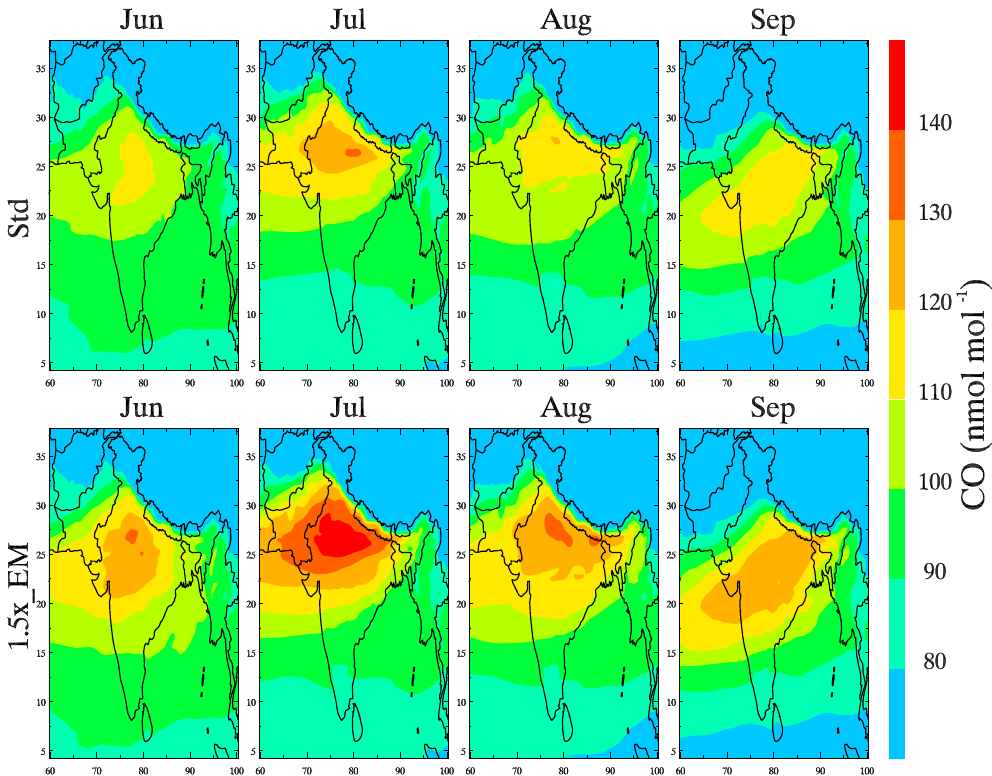
Figure 9. Comparison of monthly average horizontal distribution of CO in the upper troposphere (116 to 211hPa) over India from the Std simulation (top panel) and 1 . 5 × _EM simulation (bottom panel) during June, July, August and September 2008.